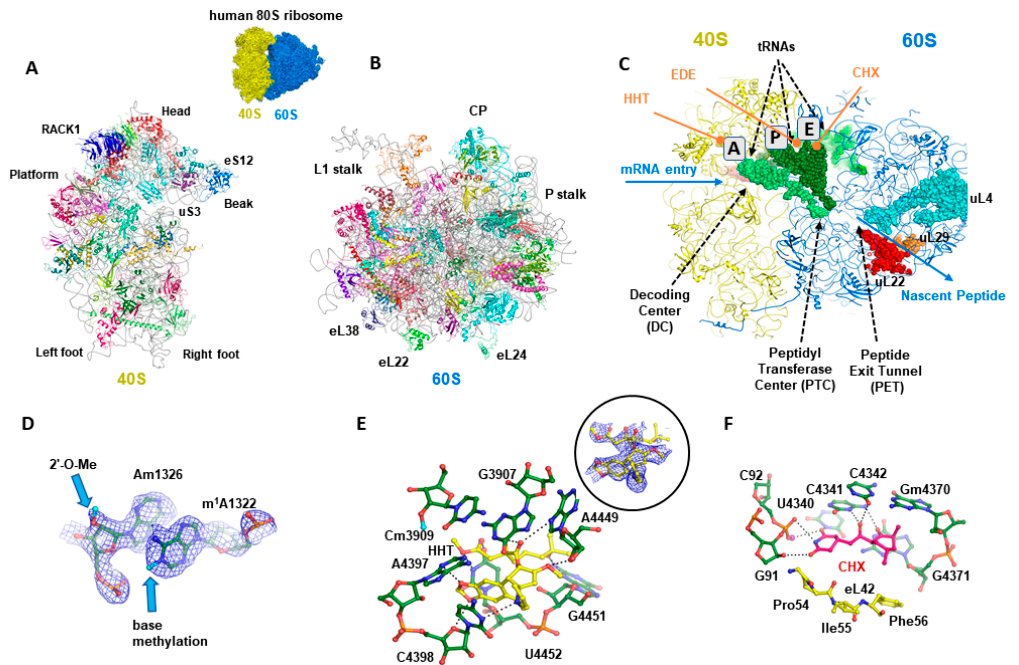
Figure 1. Structural analysis of the human 80S cytosolic ribosome. ( A , B ) Structure overview of the 40S and 60S ribosomal subunits of the human ribosome (atomic model derived from the cryo-EM structure of the 80S human ribosome [9,10]. ( C ) Typical functional sites on the ribosome, which are directly relevant for binding of inhibitors. ( D ) Detailed features in the high-resolution cryo-EM of the human 80S ribosome in which chemical modifications are visible [10]. ( E ) Structure of the human 80S ribosome complex with the HHT inhibitor (the inset shows the cryo-EM mpa density corresponding to the ligand). ( F ) Structure-based drug design: CHX as a case study; hydrogen bonds are indicated by dotted lines; eL42 is eukaryote-specific ribosomal protein which could be targeted to generate specificity using chemically modified ligands. CP: central protuberance; A: aminoacyl site; P: peptidyl site; E: exit site. CHX: cycloheximide; HHT: homoharringtonine; EDE: edeine.